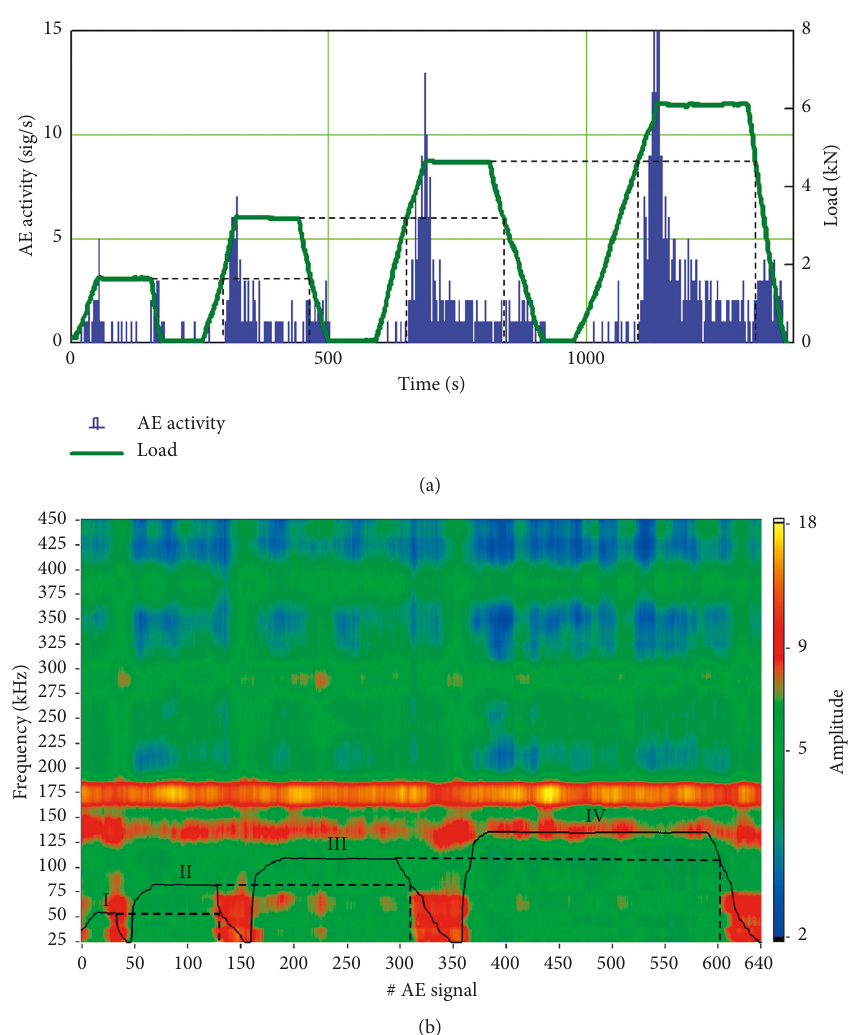
Figure 6: AE activity upon loading a sample from the second group of the “A” series (a) and an example of a processed spectrogram with superposition of P ( N )